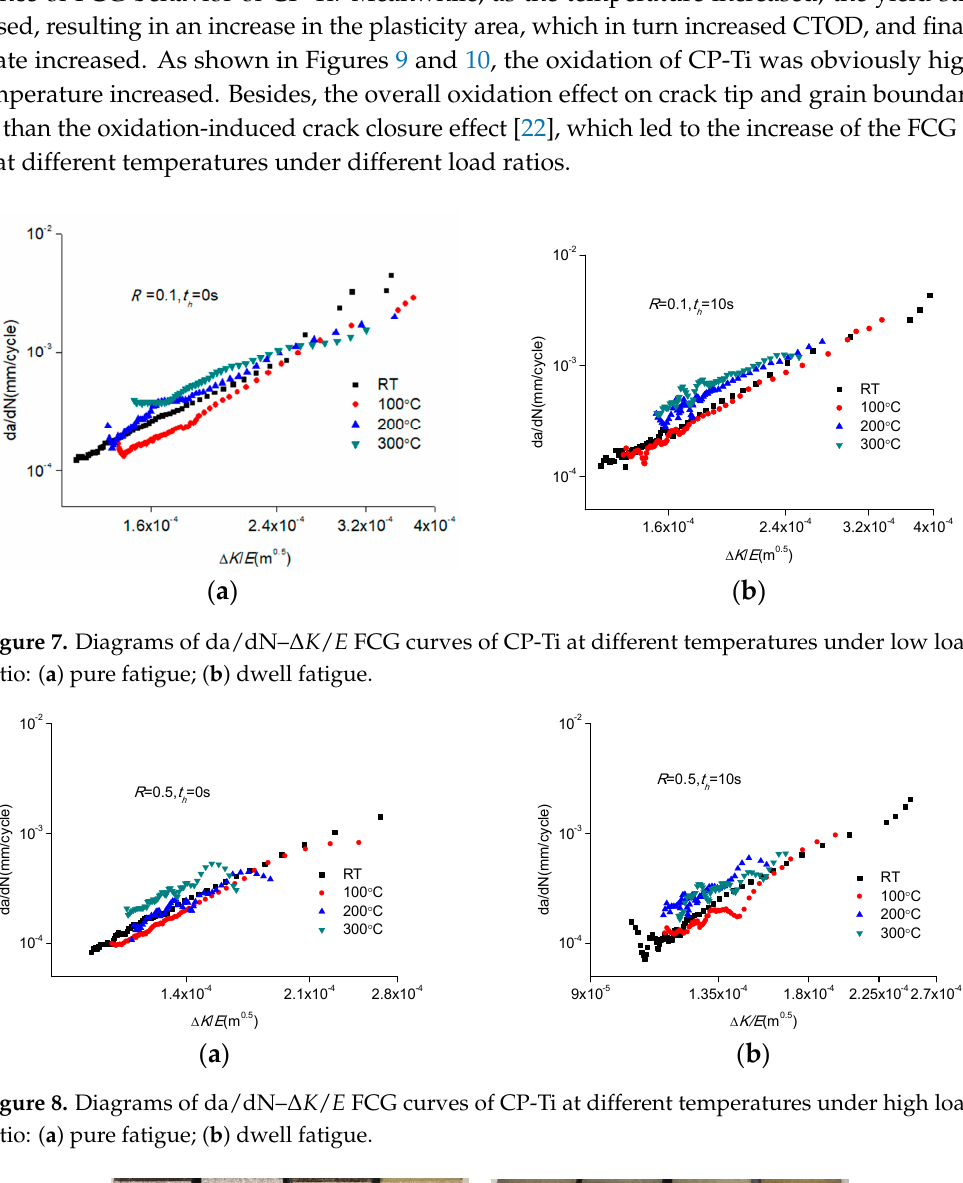
ratio: ( a ) pure fatigue; ( b ) dwell fatigue.